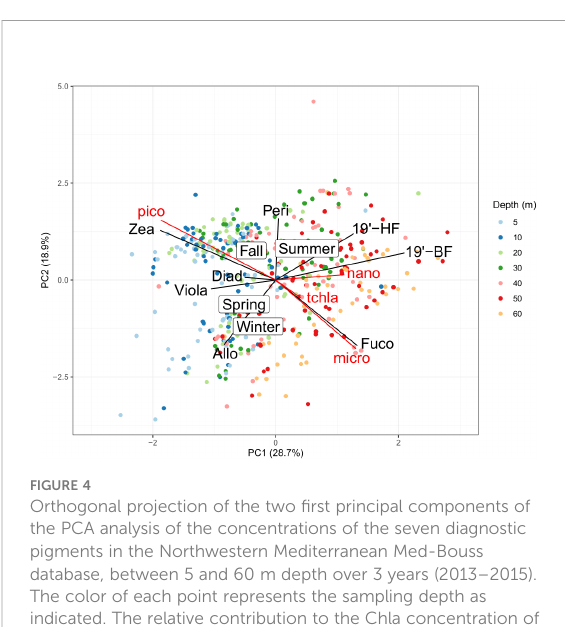
FIGURE 4 Orthogonal projection of the two fi rst principal components of the PCA analysis of the concentrations of the seven diagnostic pigments in the Northwestern Mediterranean Med-Bouss database, between 5 and 60 m depth over 3 years (2013 – 2015). The color of each point represents the sampling depth as indicated. The relative contribution to the Chla concentration of each of the three phytoplankton size classes and the seasons are superimposed as supplementary variables onto the PCA projection